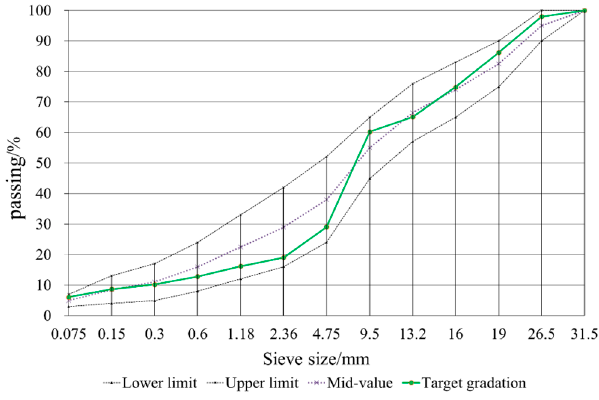
Figure 1. Grading curve of AC-25.